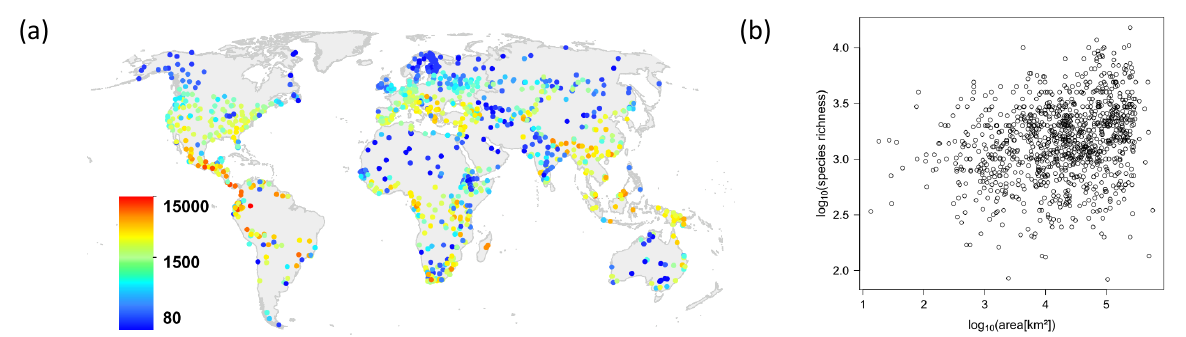
Figure 1. (a) Geographic distribution of richness data for vascular plants used in the analysis (n=1032, after Barthlott et al. 2005, Kier et al. 2005). Dots represent centres of geographical units. Geographical units differ in size, and spe- cies counts have not been standardized. (b) Observed relationship of log each geographical unit in (a). Figure reproduced with publisher’s permission from Gerstner et al.